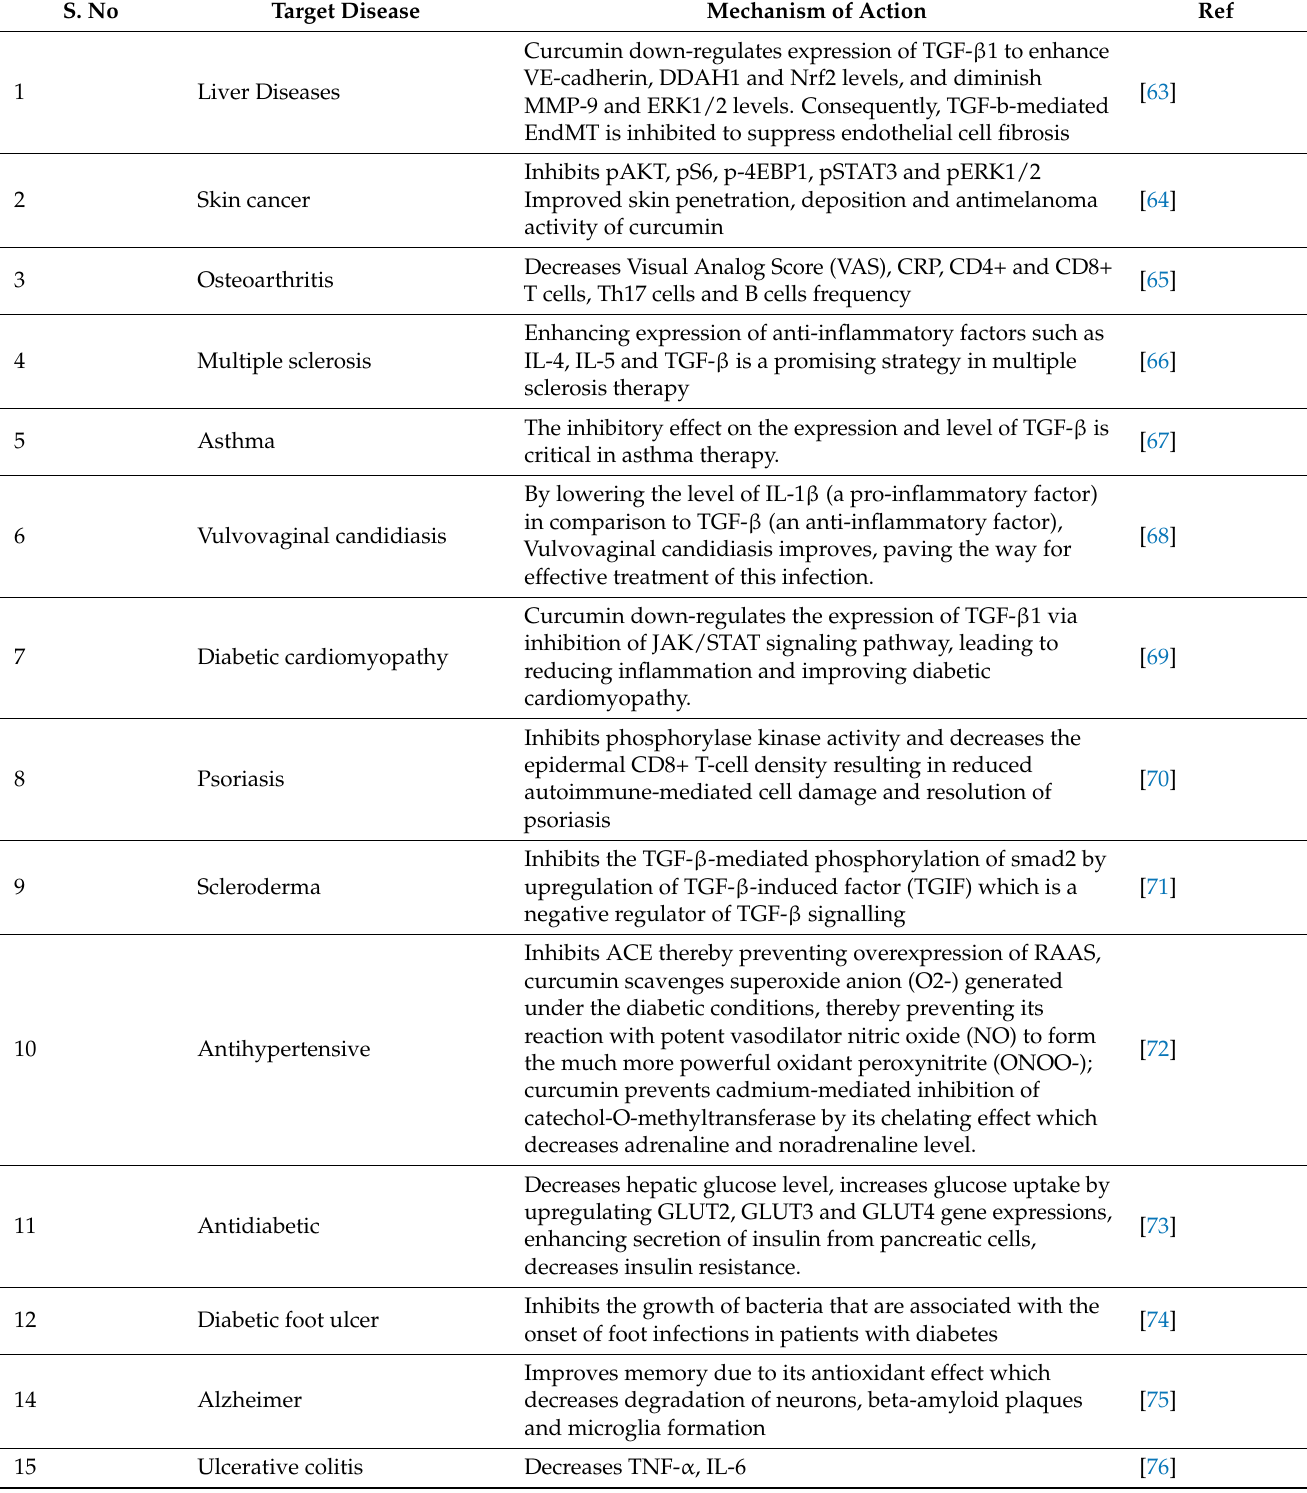
Table 2. Curcumin’s potential for biomedical